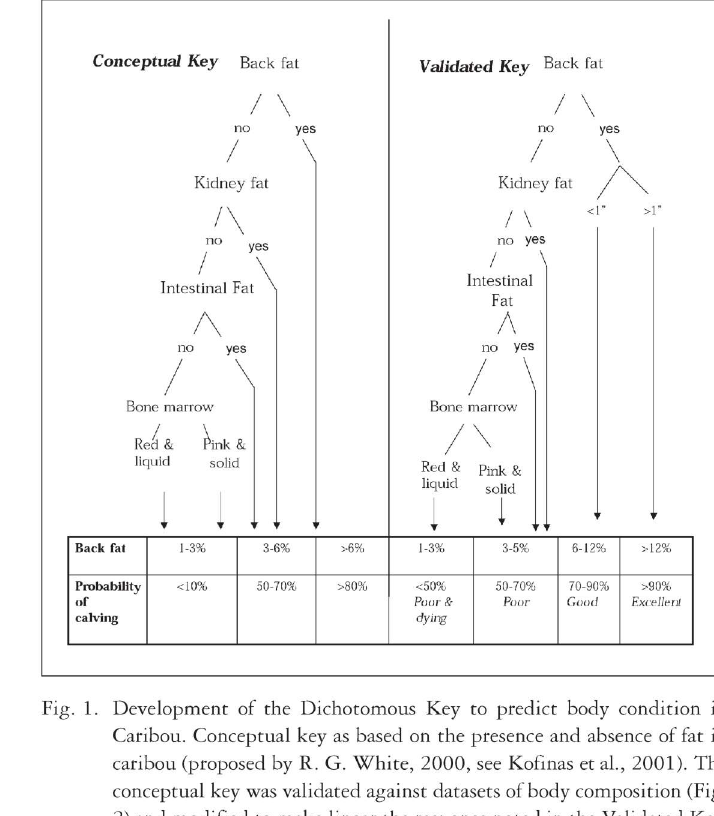
mals in the Yellowknife/McKinley Point area.